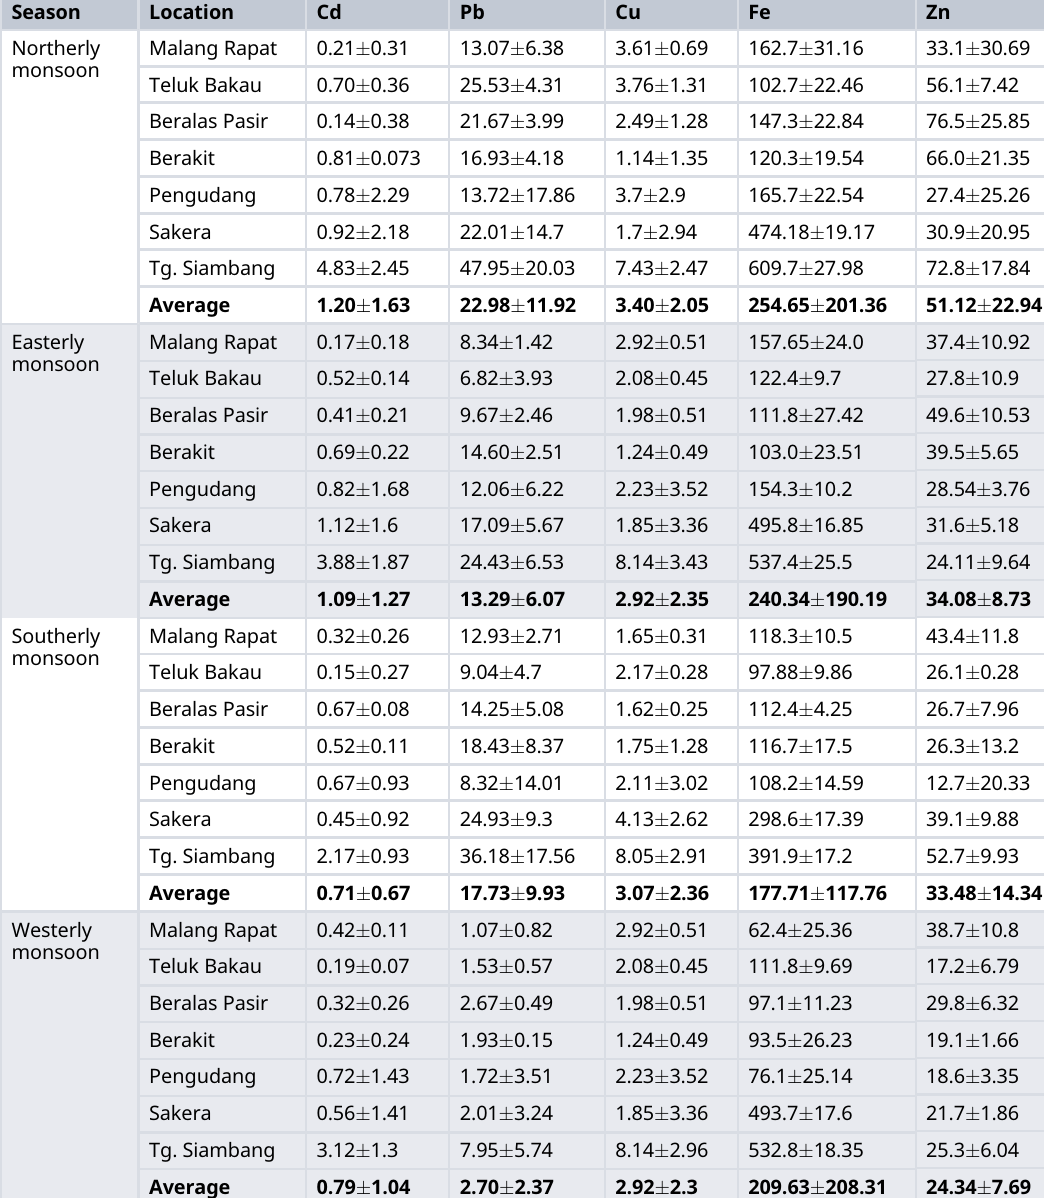
Table 1.Averageconcentration of heavymetal ( μ g/g)of Cd,Pb,Cu,Fe,and Zninthe Caulerpa racemosa during Northerly – Westerly monsoon in Bintan Island coastal